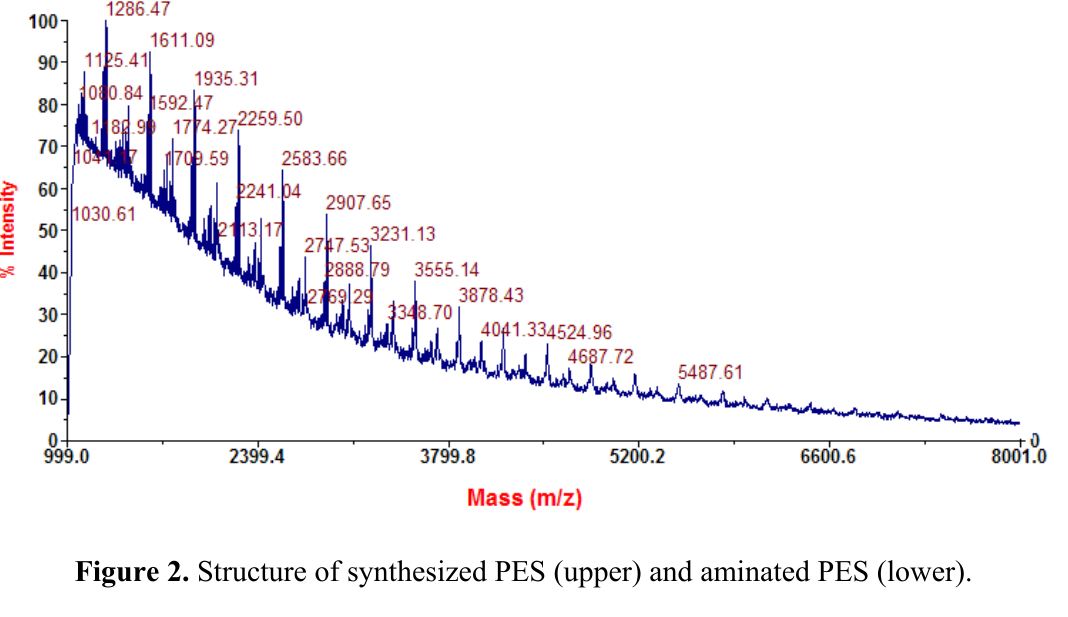
Figure 1. MALDI-TOF spectrum of the synthesized PES.